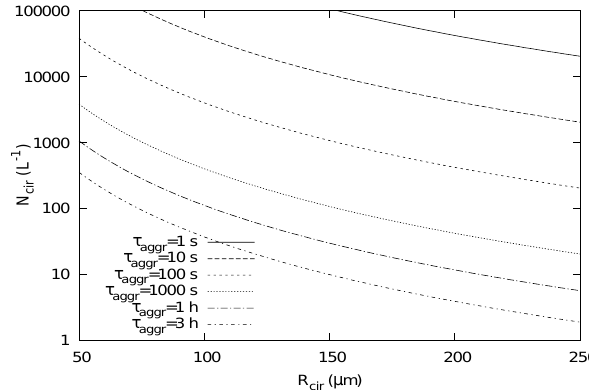
Fig. 2. Aggregation time scale for the removal of contrail ice crys- tals by sedimenting cirrus ice crystals as a function of the mean cir- rus crystal radius ¯ R cir and the cirrus crystal number concentration N cir . Note that only parameter combinations below the the main di- agonal can be considered realistic in cirrus clouds; thus aggregation timescales are typically of the order hours.